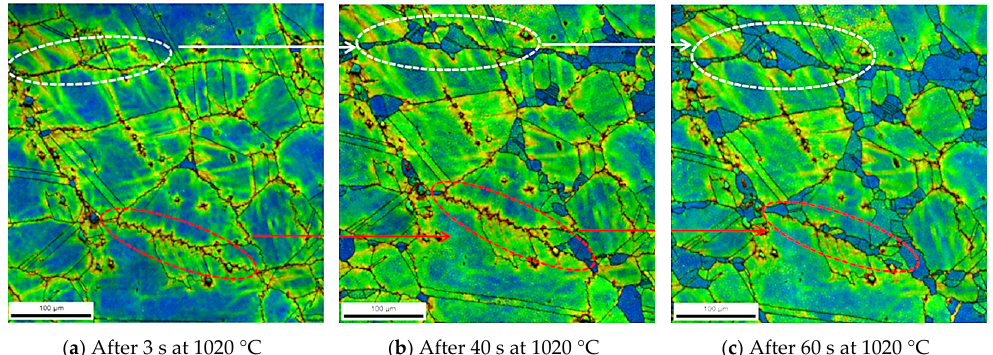
Figure 3. Microstructure evolution of sample A (initial DRX volume fraction = 2%) after successive post ‐ dynamic annealing steps at 1020°C (cumulated holding times are indicated below each micrograph). Intragranular misorientation GOS maps superimposed with the Pattern Quality map. Scale bar: 100 μ m. Grain boundaries (>15°) in black and twin boundaries (60° <111>) in white. G OS color ‐ coding from 0 to 9°: . Figure 4. Same data as in Figures 3.b ‐ f ‐ g, but with a color coding related to the Kernel Average Misorientation (KAM) value instead of the GOS in Figure 3. Grain boundaries (>15°) black. KAM color ‐ coding from 0 to 5°: